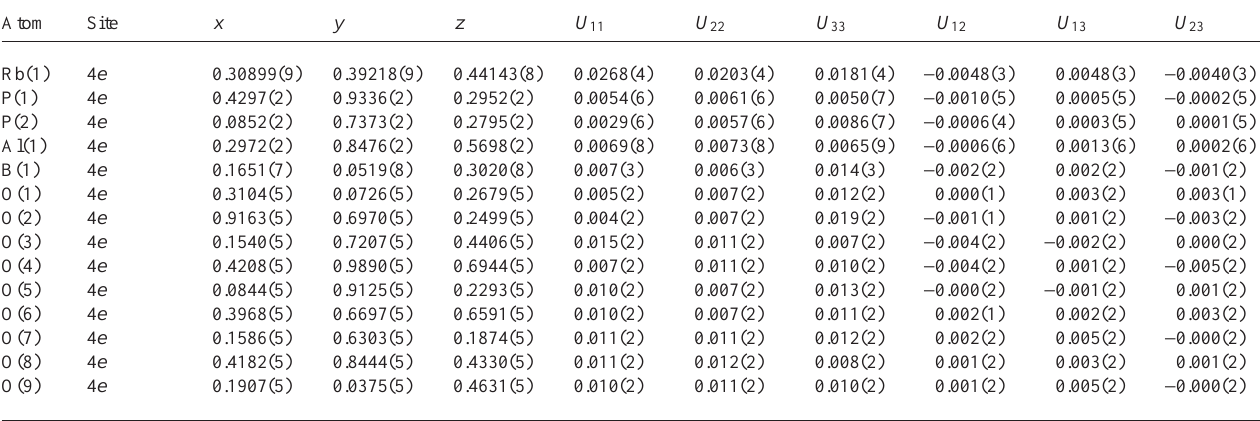
Table 3. Atomic coordinates and displacement parameters (in Å 2 )